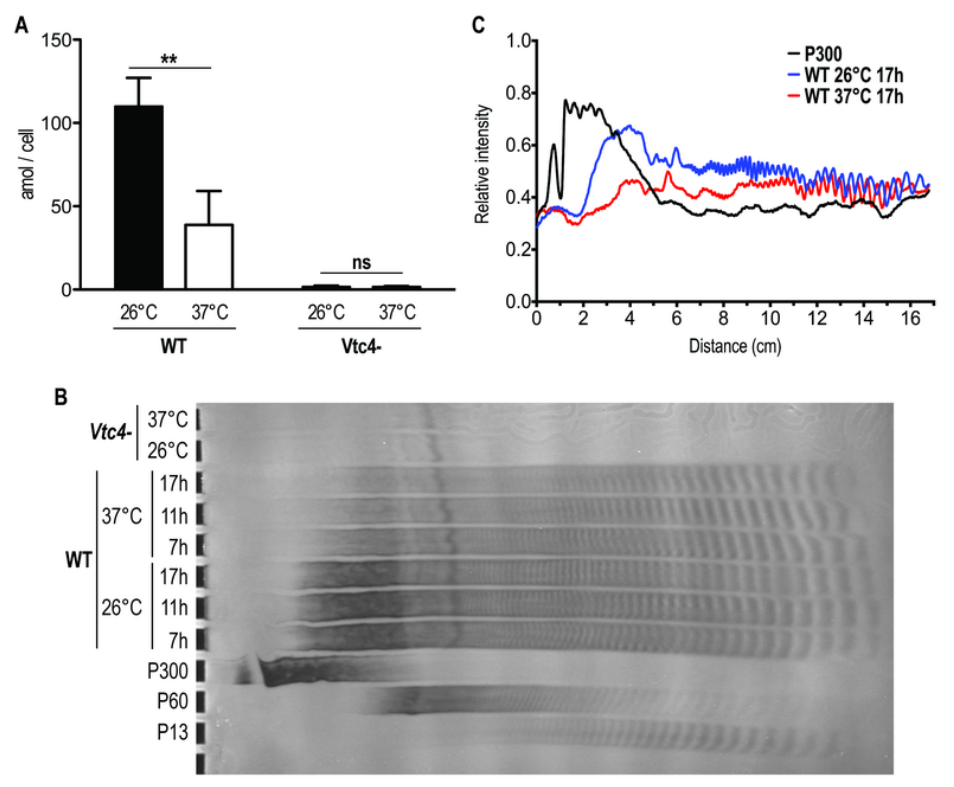
FIGURE 9: Higher temperature increases Leishmania consumption of polyP. (A) L. major logarithmic phase (day 3 post dilution) promastigotes were incubated for 6 hours at 26°C or 37°C. PolyP was quantified in attomole/cell (amol/cell) and represented as absolute values. Results of a pool of 3 independent experiments were expressed as mean ± SD of polyP levels. Statistical significance was assessed by Two-way ANOVA ; ** p < 0.01, ns: non-significant. (B) PolyP was extracted from logarithmic phase (day 3 post dilution) L. major promastigotes exposed at differ- ent temperatures for the indicated time. PolyP chains were separated by gel electrophoresis and visualized by negative DAPI staining on a 35% polyacrylamide gel. PolyP standards represent an average of the respective sizes ranging from 13 up to 300 residues (P13, P60 and P300). (C) Quantification of polyP chains consumption by ImageJ of lanes of Fig. 9B representing polyP chains in Leishmania parasites cultured at 26°C (blue line) or exposed to a 37°C heat shock for 17h (red line). The black line represents the P300 standard and was included for comparison. The x axis represents the distance from the top of the gel and the y axis the relative intensity of the